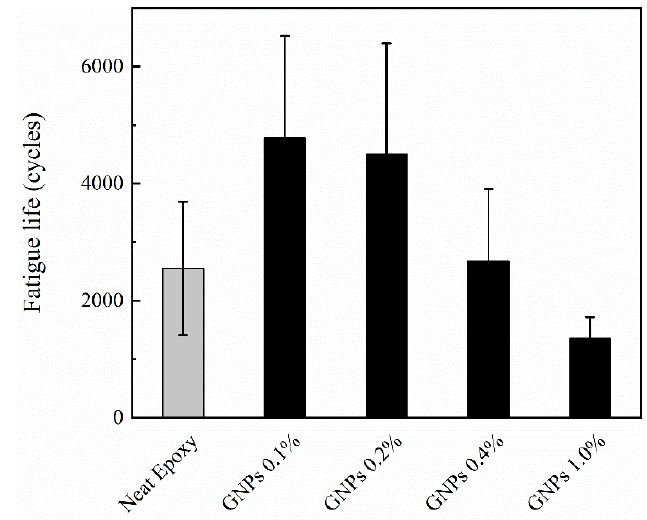
Figure 5. Influence of graphene nanoplatelets concentration on fatigue life of multiscale GFRP nanocomposites.